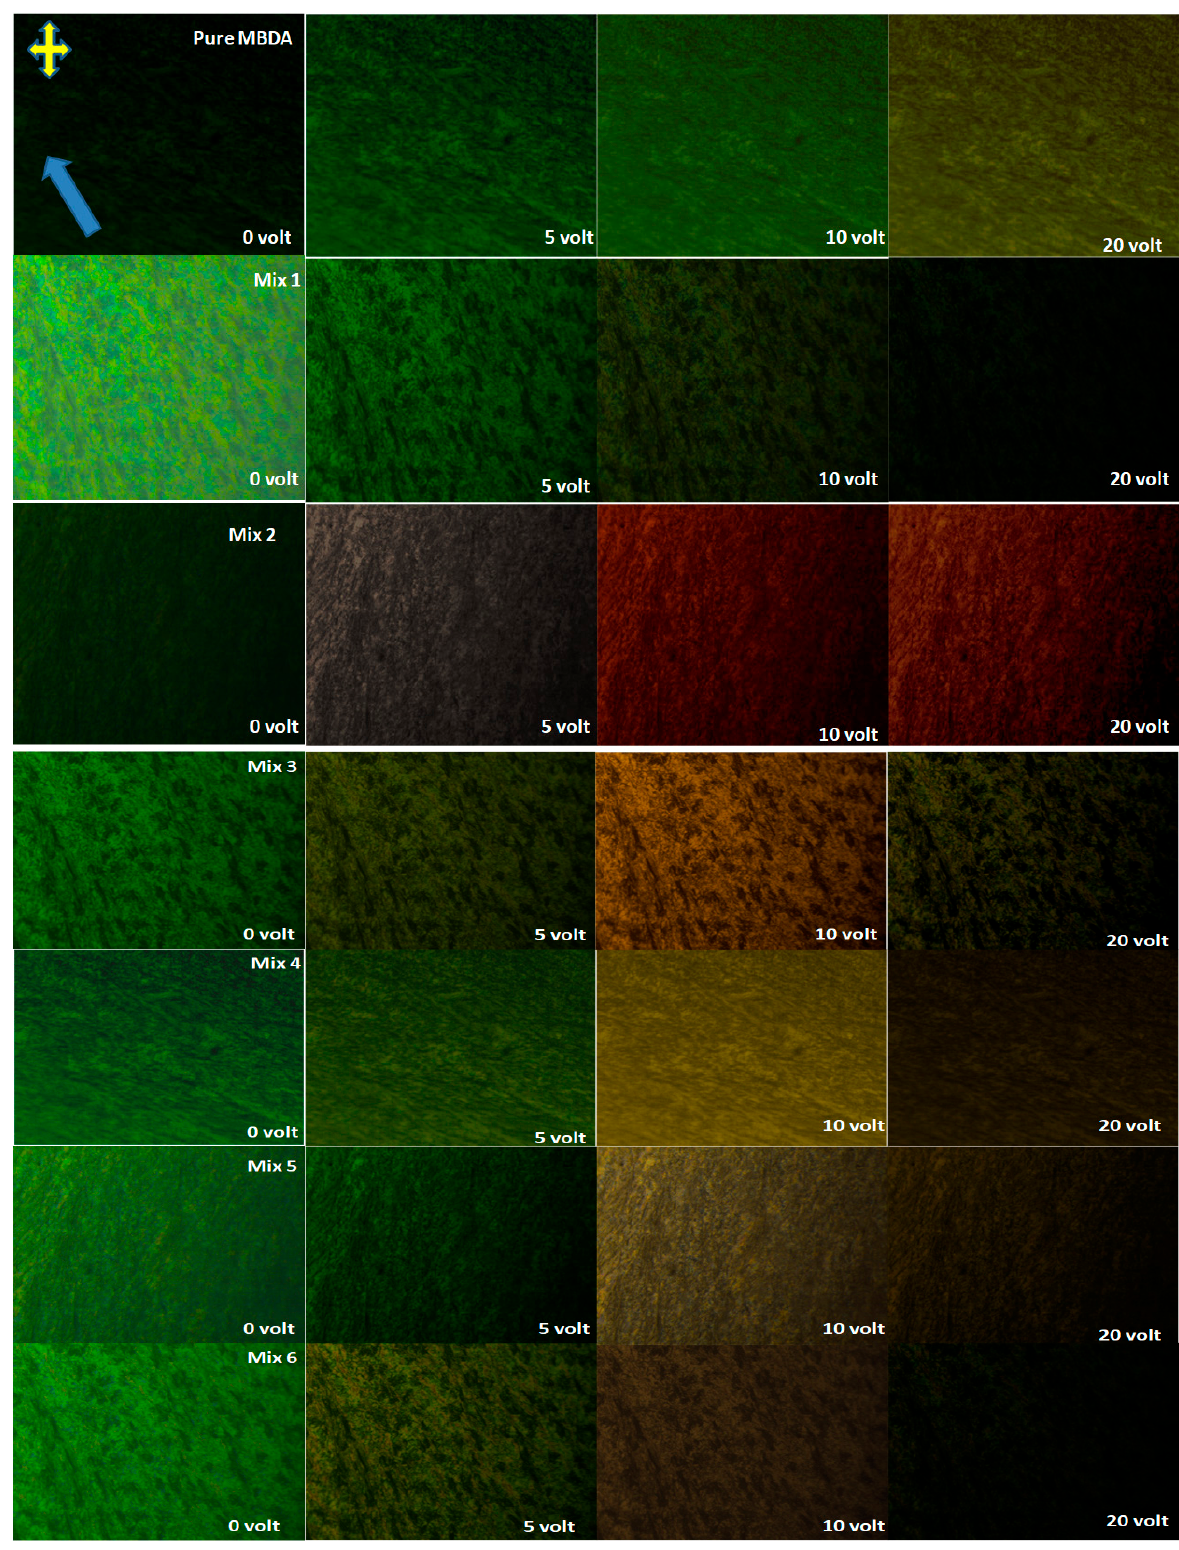
Figure 3. Polarizing optical micrographs for pure nematic MBDA and its mixture with core/shell quantum dots (Mix 1 to Mix 6) at a temperature of 56 °C with applied voltage of 0 V , 5 V, 10 V, and 15 Vat a scale of 100 μ m.